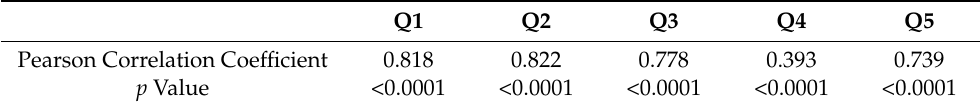
Table 2. Correlations between scores for each questionnaire and total score of Asthma Control Test. Q1